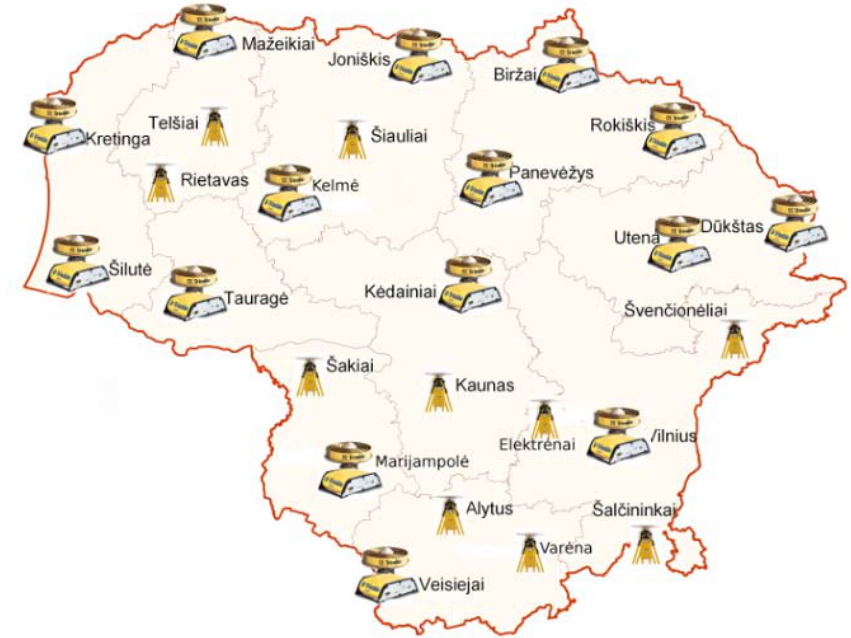
Fig. 1. Distribution of LitPOS stations